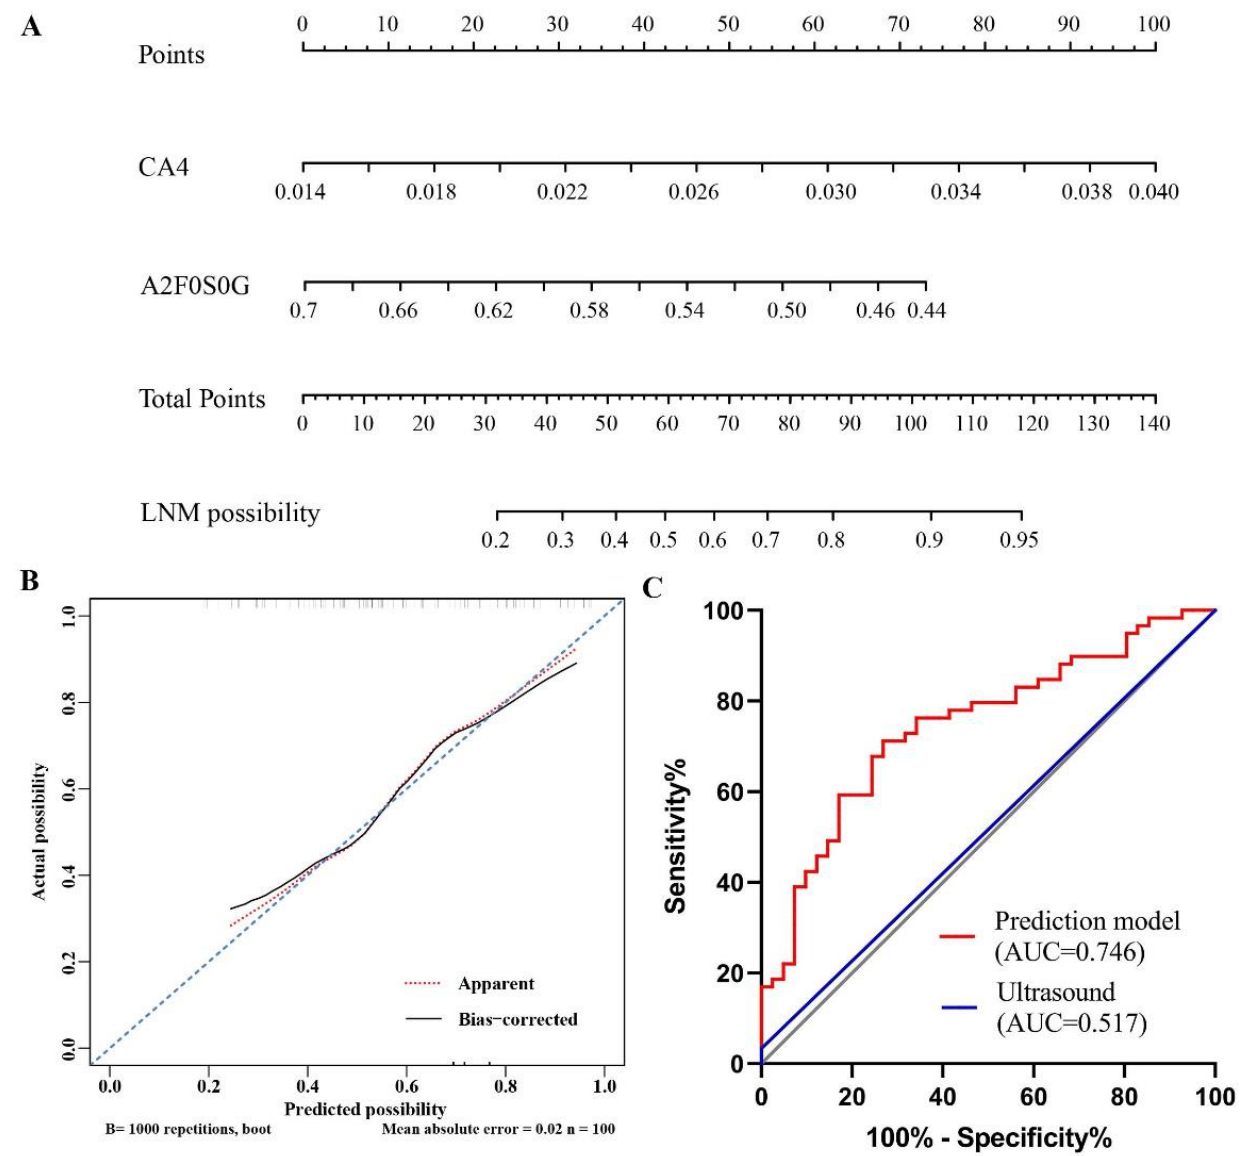
Figure 5. The ultrasound and the binomial logistic regression model constructed from glycans for preoperative prediction of LNM in papillary thyroid microcarcinoma. ( A ) The visualized nomogram of the logistic regression model; ( B ) Calibration curve of the nomogram. The 45 ◦ dashed line represents the ideal predictions. The solid line shows a bias-corrected curve. The dotted line shows the nomogram probability; ( C ) ROC curves of the nomogram and ultrasound for predicting the probability of papillary thyroid microcarcinoma with LNM. LNM, lymph node metastasis; ROC, receive operating characteristic; AUC area under the curve.